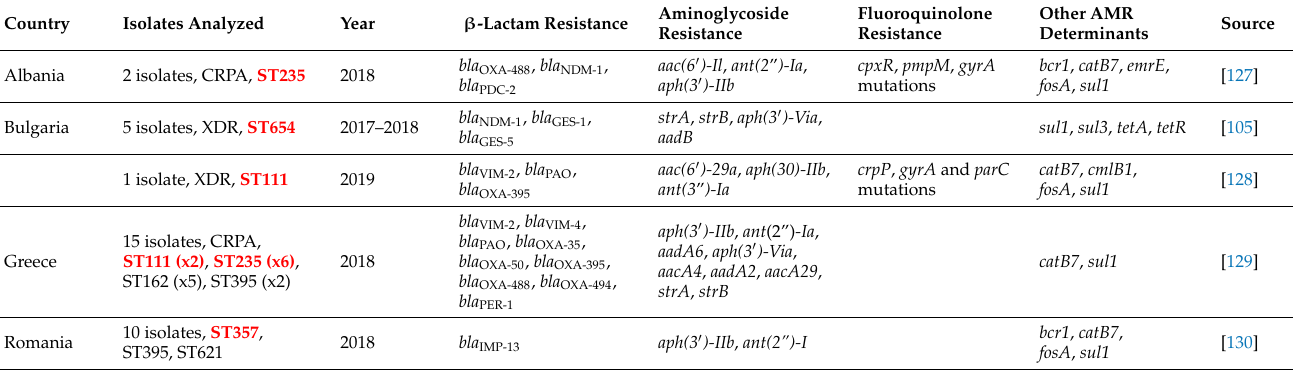
Table 1. Whole-genome sequencing-based resistome studies of carbapenem-resistant, MDR, and XDR P. aeruginosa isolates from the